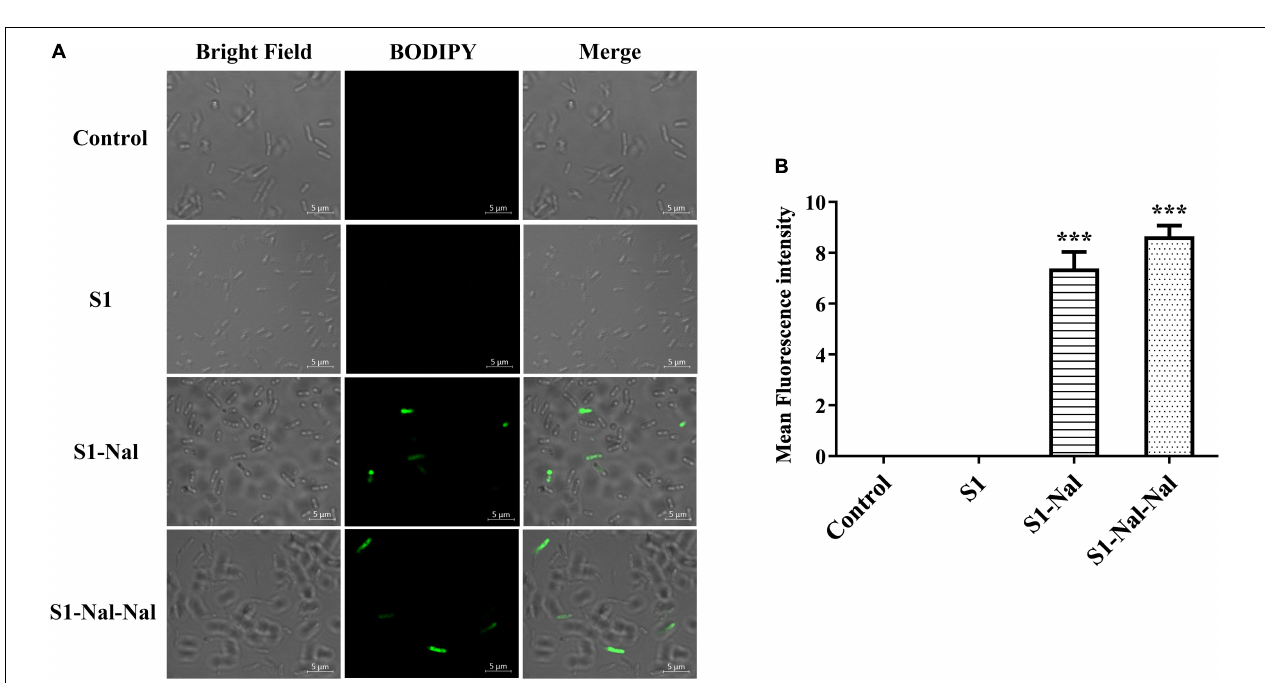
FIGURE 3 | S1-Nal and S1-Nal-Nal increase the uptake of BODIPY-labeled vancomycin in A. baumannii . (A) Fluorescence images of 10 7 CFU/ml A. baumannii BCRC 14B0097 treated with 0.5 × MIC of S1, S1-Nal, and S1-Nal-Nal at 37 ◦ C for 30 min, then treated BODIPY-labeled vancomycin for 30 min (scale bar represents 5 µ m). (B) Mean fluorescence intensity of S1, S1-Nal, and S1-Nal-Nal treated in A. baumannii BCRC 14B0097. Samples treated with BODIPY-labeled vancomycin only served as a control. Results are presented as means ± SEM, *** P < 0.001 compared with control. n.s., no significant differences.